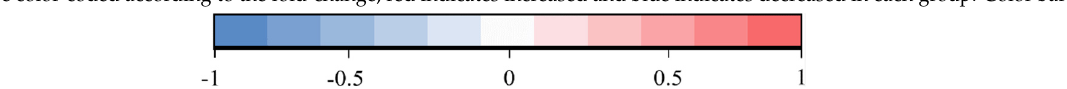
Table 1. Differences in plasma metabolism between hypoxia group and control